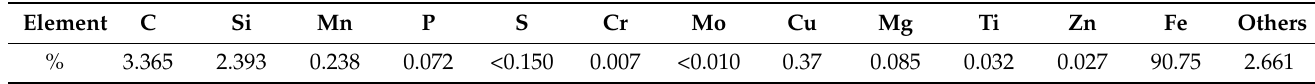
Table 1. Chemical constitution of pearlitic ductile iron.